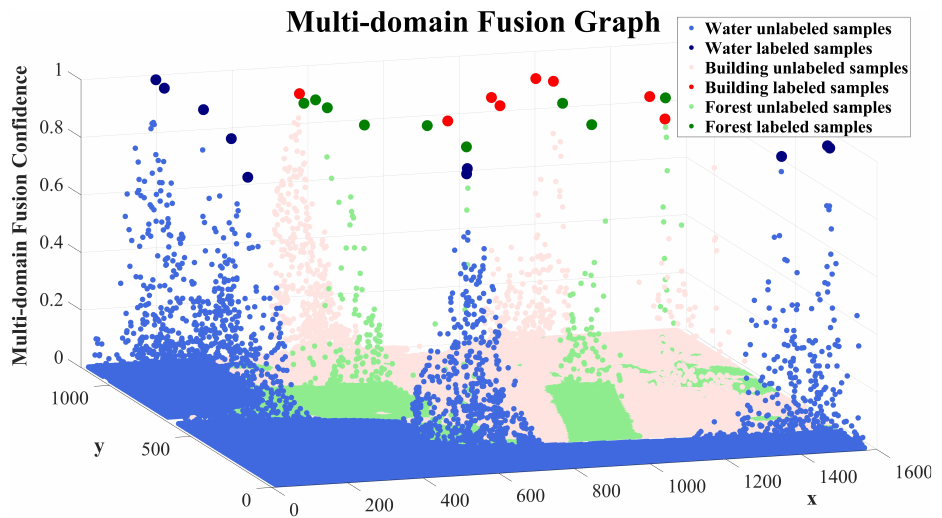
Figure 4. Multi-domain fusion